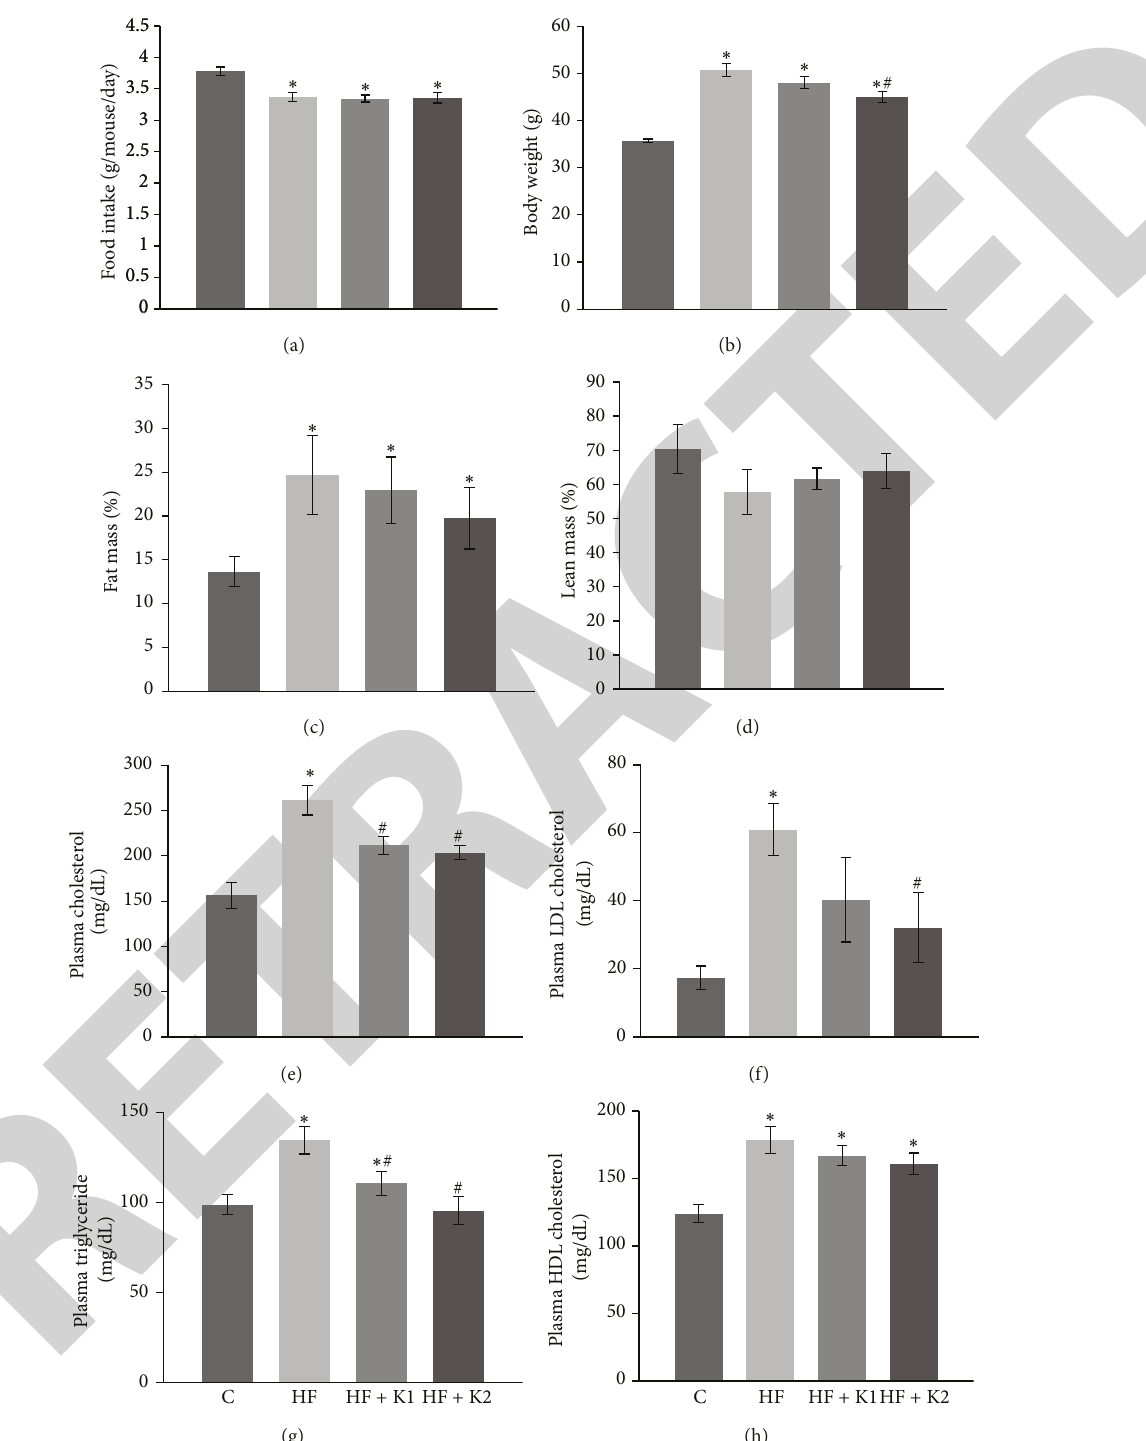
Figure 1: Kaempferol supplementation had no significant effects on food consumption but reduced body weight gain and fat mass in HF diet-fed middle-aged mice. (a) Food intake was recorded twice a week and the average daily food intake was calculated. (b) Body weight of the individual mouse was measured each week. Data shown are the average body weight of last week of feeding experiment. Body composition including fat mass (c) and lean mass (d) was measured following 5 mo of standard diet or HF feeding. At the end of the experiment, fasting plasma total cholesterol (e), LDL-cholesterol (f), triglycerides (g), and HDL-cholesterol (h) were measured in duplicated samples by using mouse ELISA kits. Data are shown as means ± SE ( 𝑛 = 12 ). ∗ 𝑝 < 0.05 versus standard diet-fed mice (C); # 𝑝 < 0.05 versus HF-fed mice. C: standard diet; HF: high-fat diet; HF + K1: HF diet containing 0.01% kaempferol; HF + K2: HF diet supplemented with 0.05%